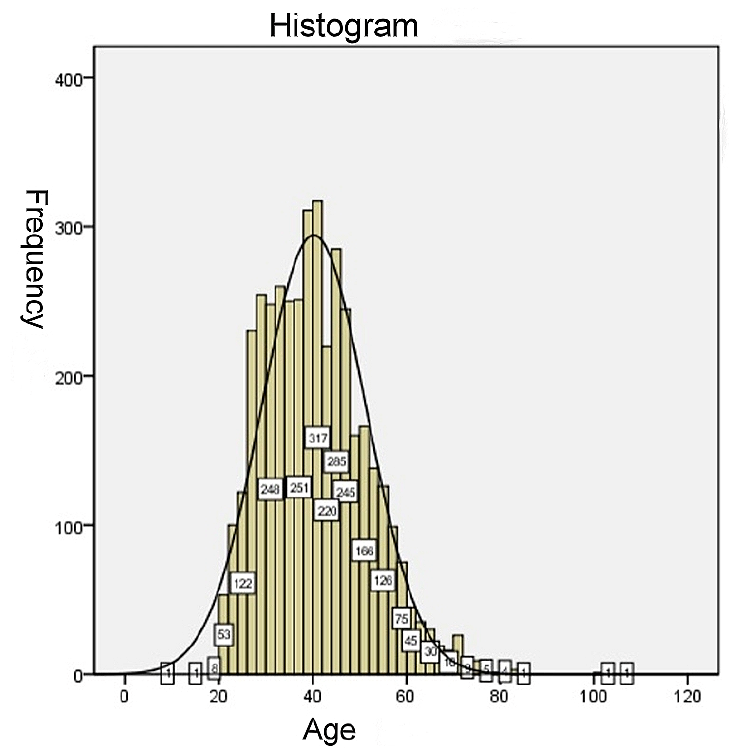
Figure 1. Age distribution of the sample.